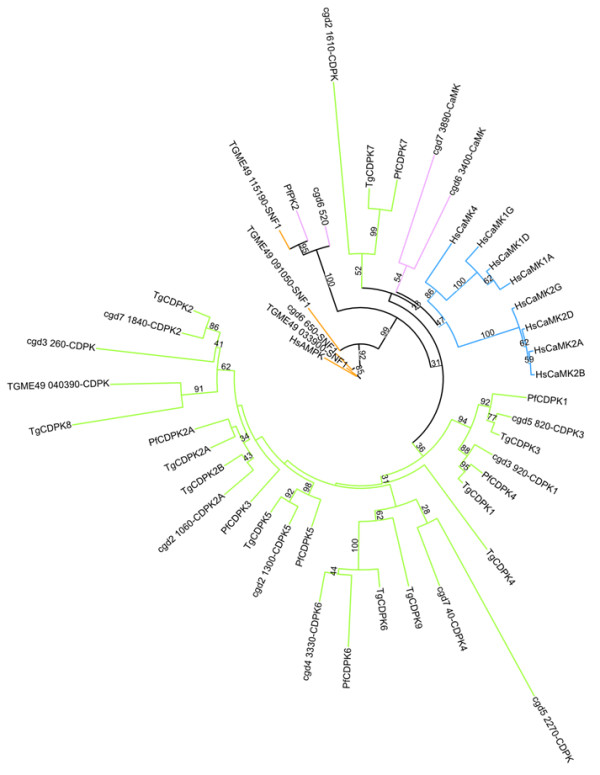
Maximum likelihood tree from a rapid bootstrap analysis for C. parvum CaMK family, also including select representatives of the CaMK families from human, P. falciparum, and T. gondii. The subfamilies are as follows: CDPK (green), CaMK (blue), SNF1/AMPK (orange), and potential apicomplexan CaM-binding kinases (pink). Note that although PFB0815w is annotated as CDPK1, it is the orthologue to TgCDPK3 (TGME40_105860) and PF07_0072 is annotated as PfCDPK4, but is actually the orthologue to TgCDPK1 (TGME49_101440).